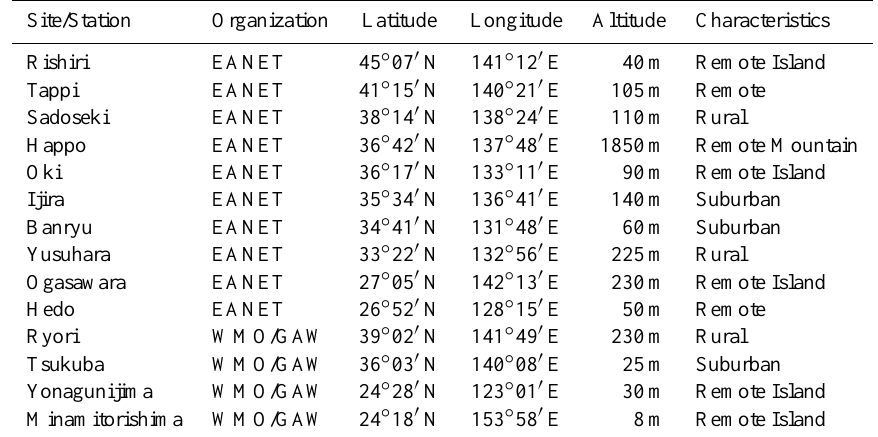
Table 1. List of EANET Measurement Sites and WMO/GAW Stations Used.